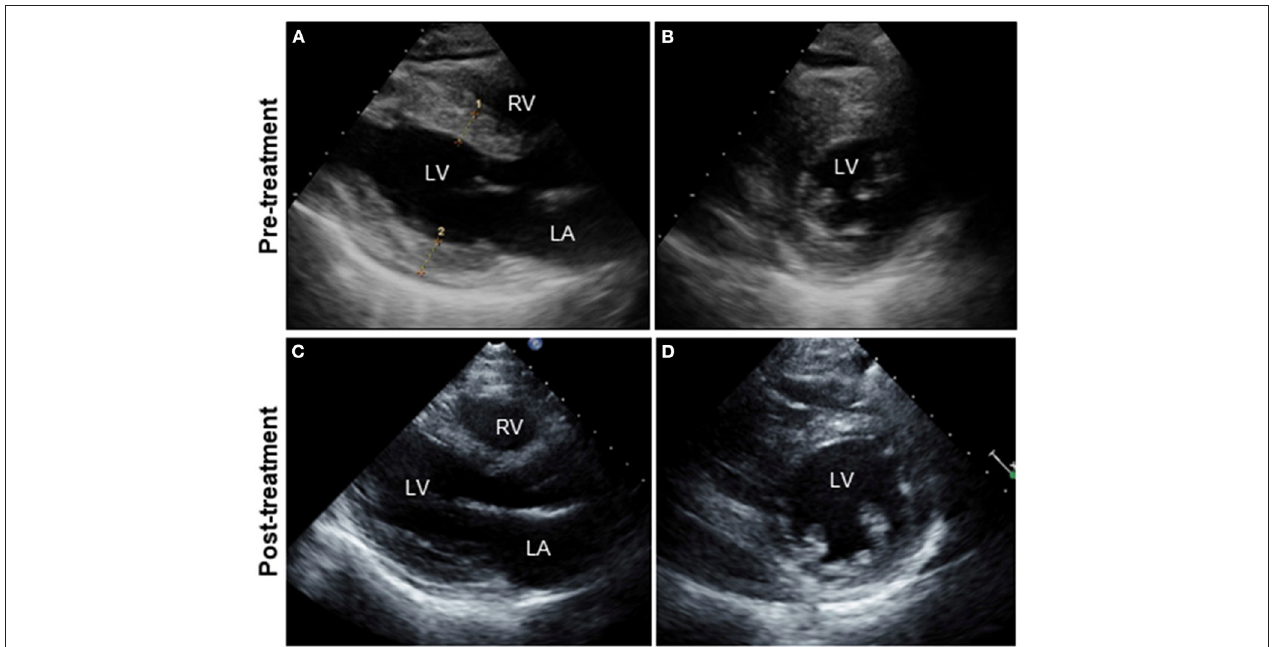
FIGURE 2 | Serial TTE. Parasternal long-axis (A,C) and short-axis views (B,D) . TTE on admission showing diffuse and symmetrical LV wall thickening (13mm), decreased cavity size (LVDd: 39mm) with preserved LVEF (52%), and pericardial effusion (A,B) . Follow-up echocardiography on day 4 after intravenous pulse steroid therapy reveals a rapid and dramatic decrease in LV wall thickness (7mm) and concomitant increases in LVDd (45mm) and LVEF (72%) (C,D) . The improvement in pericardial effusion can be noted. TTE, transthoracic echocardiography; LA, left atrium; LV, left ventricle; RV, right ventricle; LVDd, left ventricular end-diastolic diameter; LVEF, left ventricular ejection fraction.